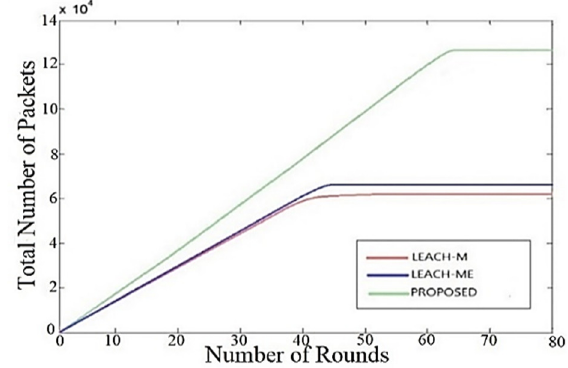
Fig. 19. The packets’ number transmitted effectively versus number of mobile sensor nodes